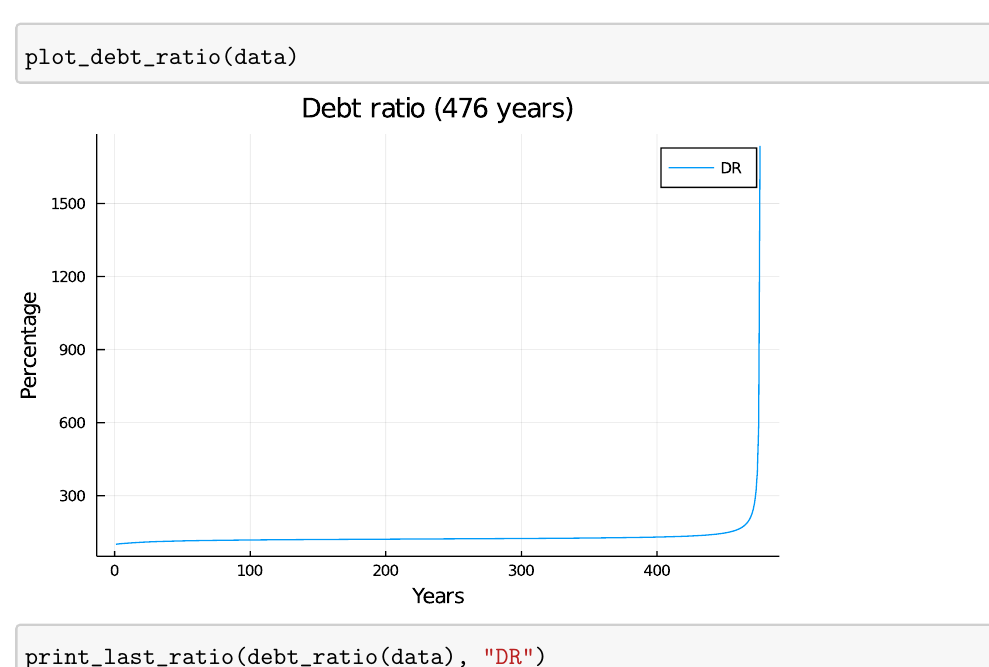
Figure 15. Growth ratio (LR = 14.9%, p = 0.8%, m = 20 years).